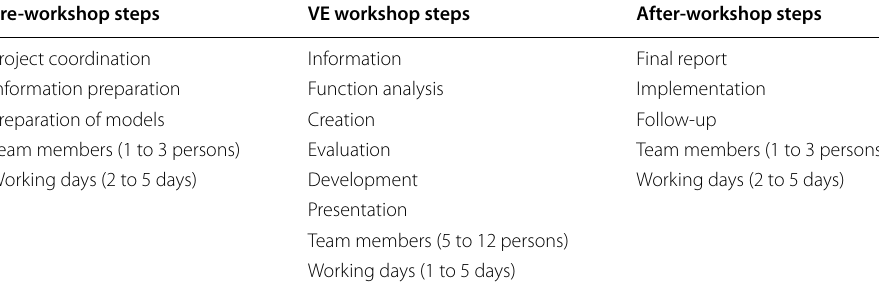
Table 1 The order of value engineering steps Pre-workshop